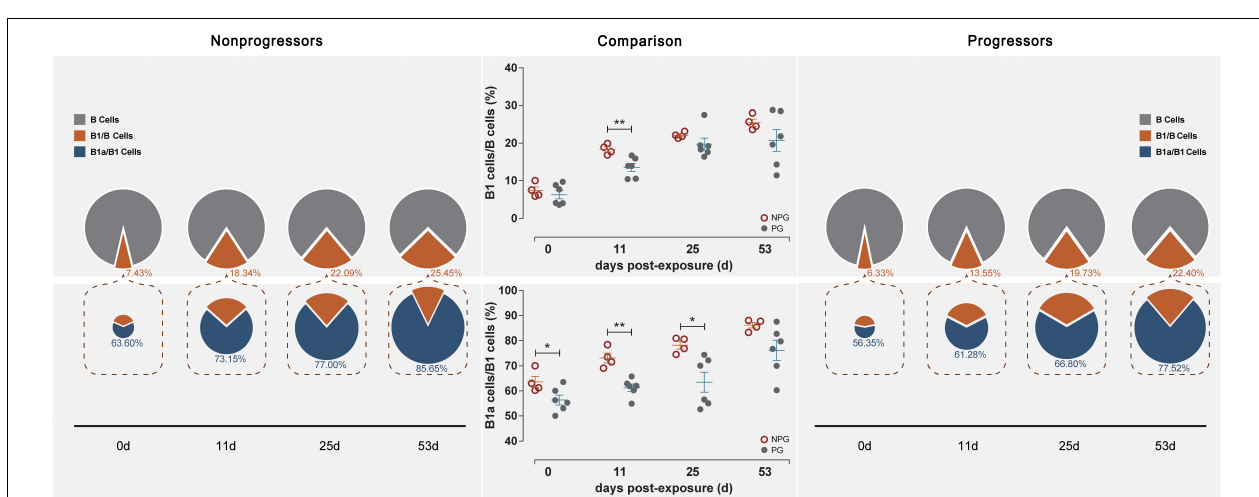
FIGURE 6 | Changes in B lymphocytes among LPMCs in non-progressive and progressive monkeys. B cell subsets, including B1/B and B1a/B1 cells, were measured among LPMCs obtained at four time points in four non-progressive monkeys and six progressive monkeys. The percentages of B1/B and B1a/B1 cells were compared between the two subgroups at each time point. Notably, increased ratios of B1/B and B1a/B1 cells were found in the four non-progressive monkeys during the early stage after initial exposure (unpaired t -test, Welch’s correction, * P < 0.05, ** P <